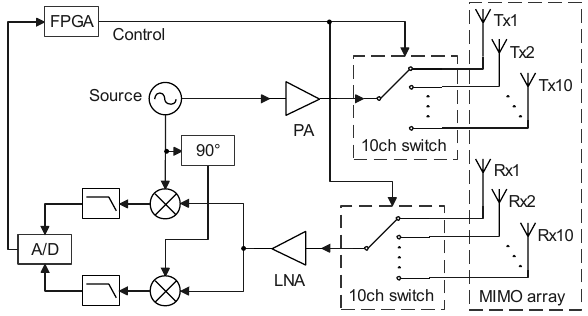
Figure 6. Block diagram of the MIMO radar system.